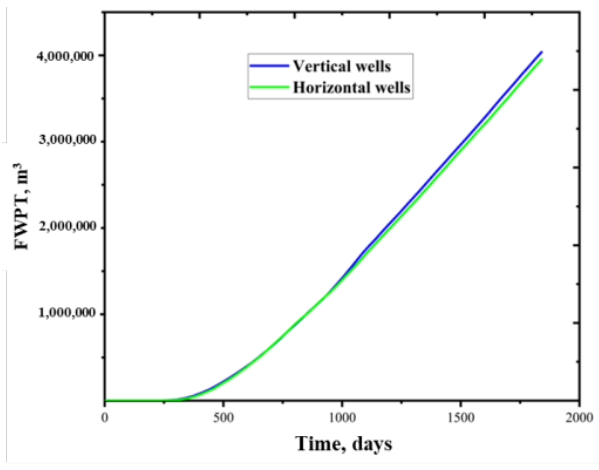
Figure 31. Comparison of field total water production rate for vertical and horizontal wells.